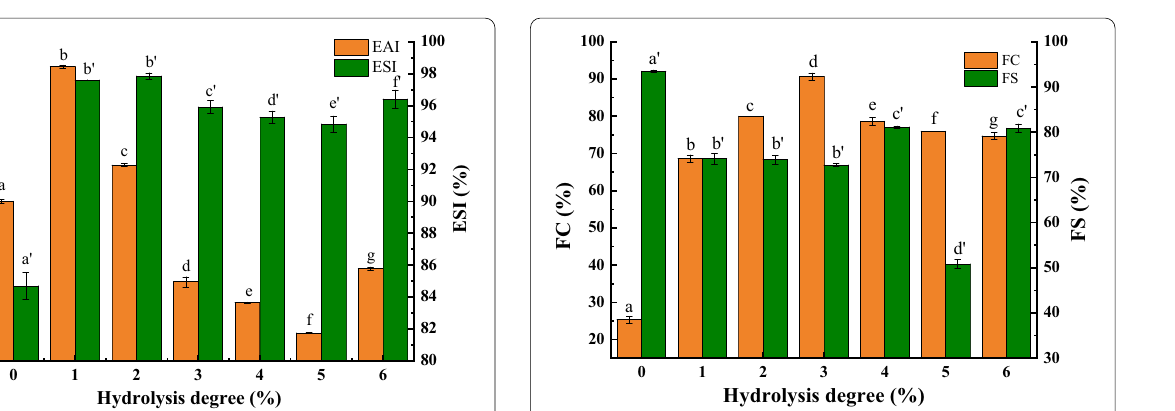
Fig. 6 Emulsification properties of SPH at 0–6% DH, respectively. EAI emulsifying activity index; ESI emulsion stability index. Values with different superscript letter are significantly different p < 0.05. a–g is used for EAI and a ′ –f ′ is used for ESI